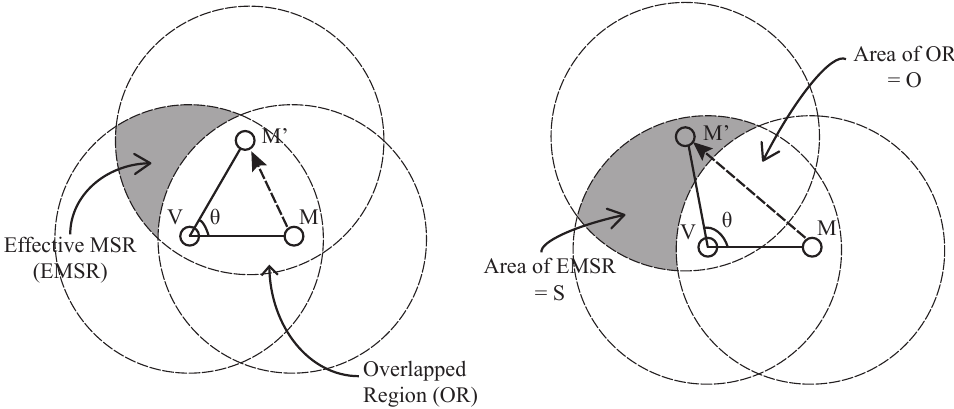
Figure 7. Analysis of the successful detection of a malicious